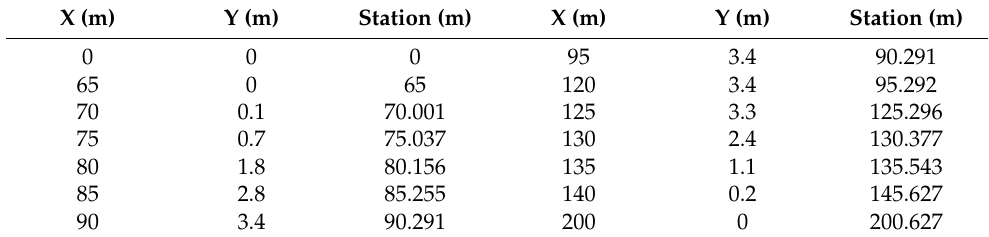
Table 4. Double-shift line road centerline discrete point table.